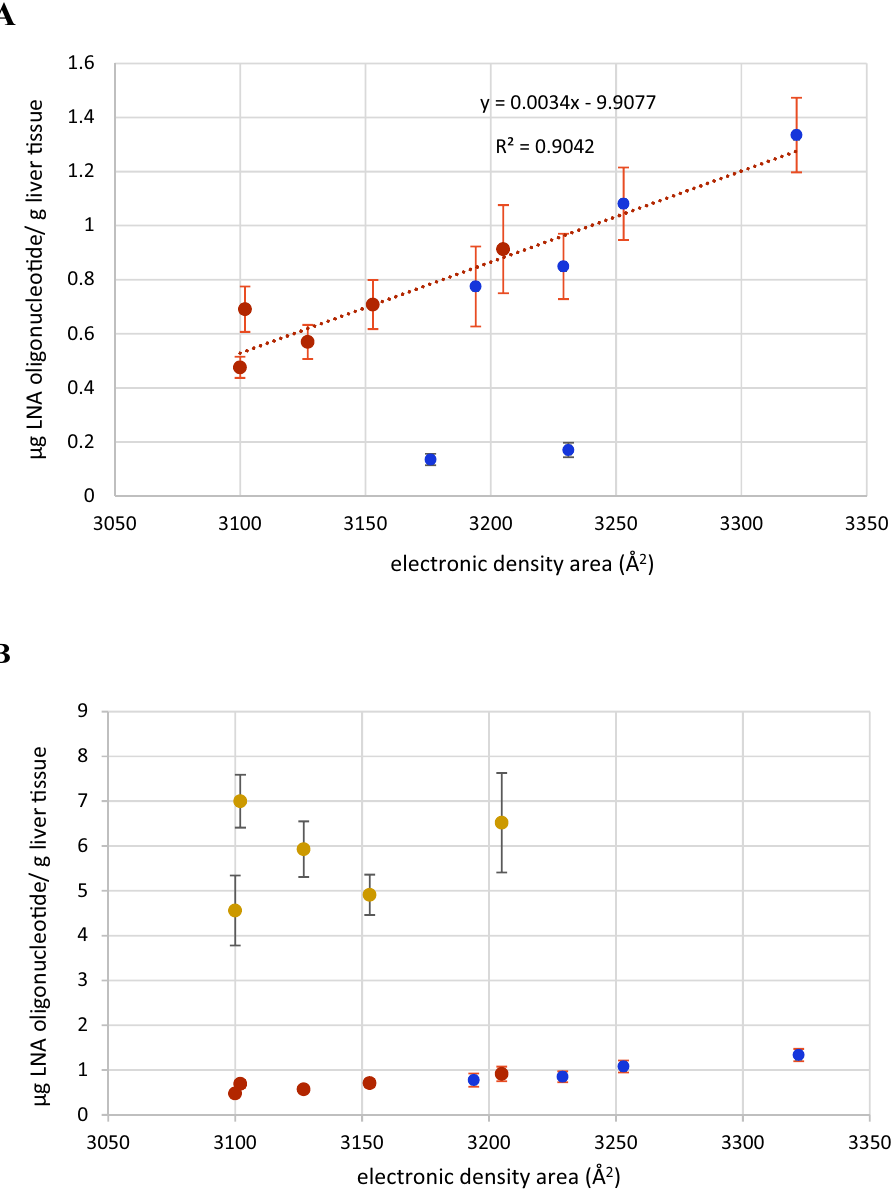
Figure 5. Correlation between electronic density area and liver uptake in mice (C57BL/6qBom) for all 11 stereo-defined LNAs. Six stereo-defined LNAs against ApoB-100 (blue circles) and five stereo-defined LNAs against Hif-1alpha (green circles). ( A ) Red: Hif-1 alpha. Blue: ApoB-100, all LNAs dose at 1 mg/kg; ( B ) All ApoB-100 LNAs dosed at 1 mg/kg (blue); all Hif-1 alpha LNAs dosed at 1 mg/kg(red) and 10 mg/kg (yellow). The R 2 values includes measurements of n = 5 mice for liver content for all LNA oligonucleotides. LNA 4 and 6 are not included in the statistics since the measured amount does not represent truly the uptake due to fast 3 ′